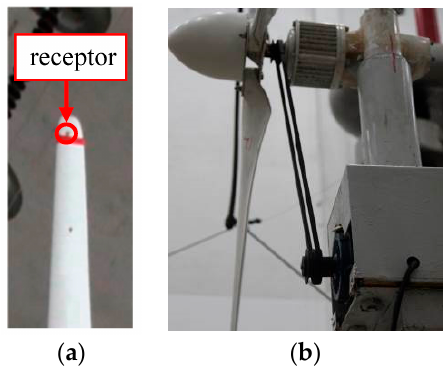
Figure 3. Diagram of typical receptors and power transmission module: ( a ) receptor; ( b ) Power transmission module.